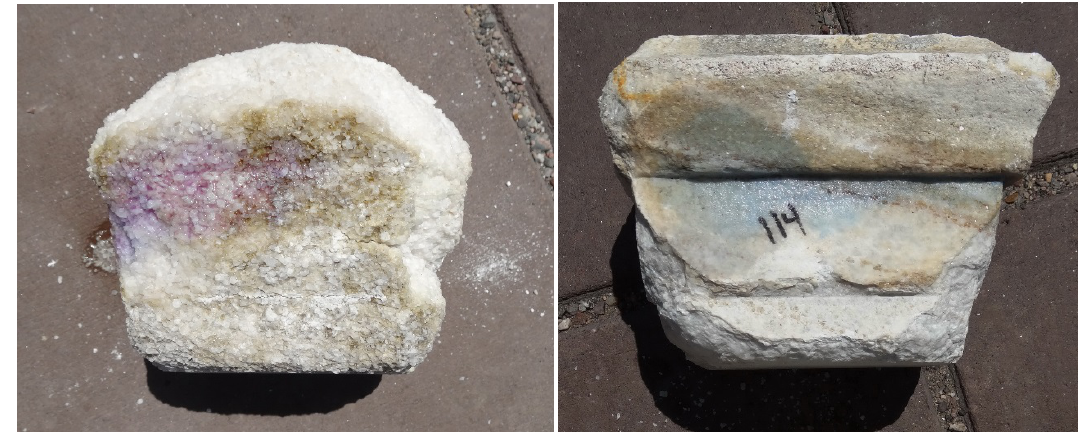
Figure 5: Field test using an alkaline reagent solution to check for magnesium on a Type 1 modillion (left) and a Type 4 modillion (right) that were shown in the previous figure. The agent quickly turned blue on the unit on the right, while remaining mostly violet colored after two minutes of exposure in the unit on the